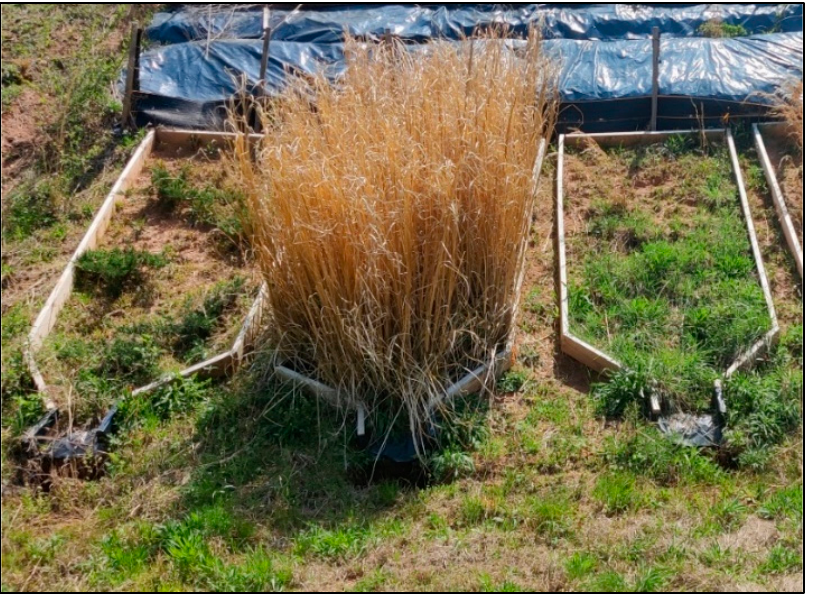
Figure 4. Final condition of the three plots where vegetation established well, photographed in April 2022. Shown from left to right are juniper, vetiver, and fescue.